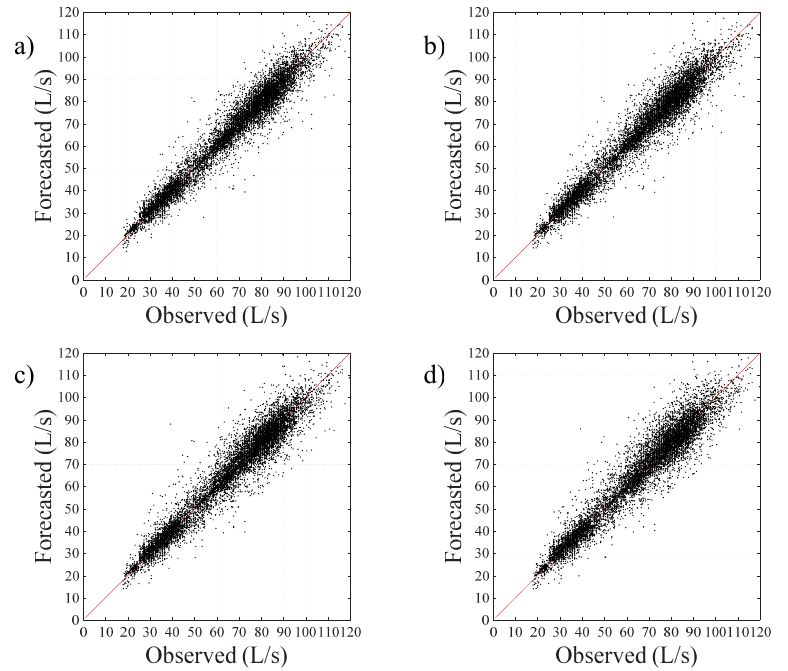
Figure 7. Scatter plot of the ( a ) 1-h-ahead; ( b ) 6-h-ahead; ( c ) 12-h-ahead; and ( d ) 24-h-ahead forecasts provided by the αβ _WDF model for the year 2000.